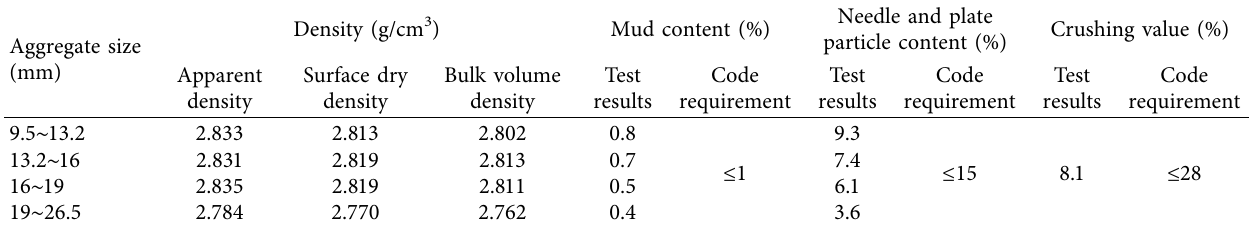
Table 1: Summary of test results of coarse aggregate.